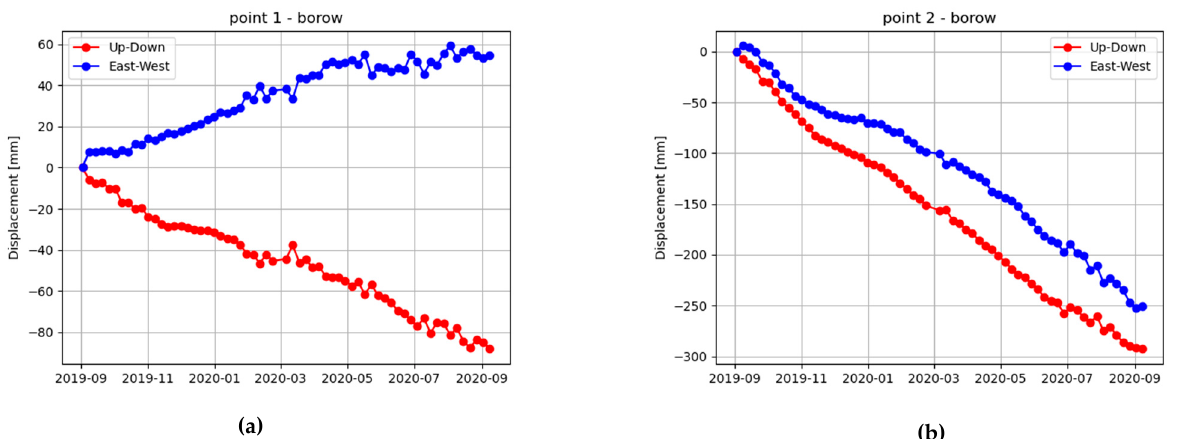
Figure 15. Time series of the extracted Up-Down (red) and East-West (blue) components associated with point 1 ( a ) and point 2 ( b ) in the deformation area surrounding Borow, as shown in Figure